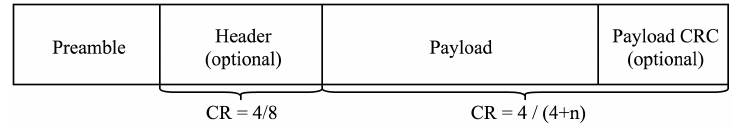
Figure 3. Structure of a LoRa frame. n ∈ { 1..4 } .